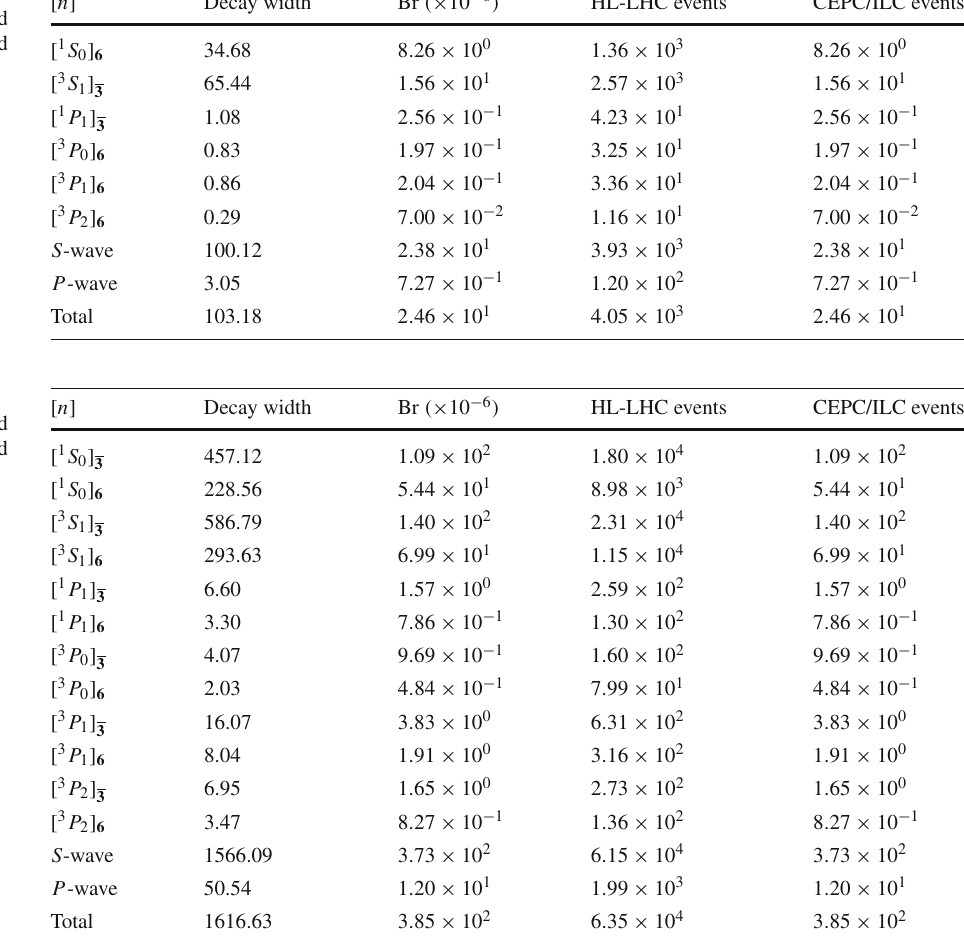
Table 1 Decay widths ( × 10 − 9 GeV), branching ratios (Br), and produced events at HL-LHC and CEPC/ILC for P -wave and S -wave (cid:2) cc